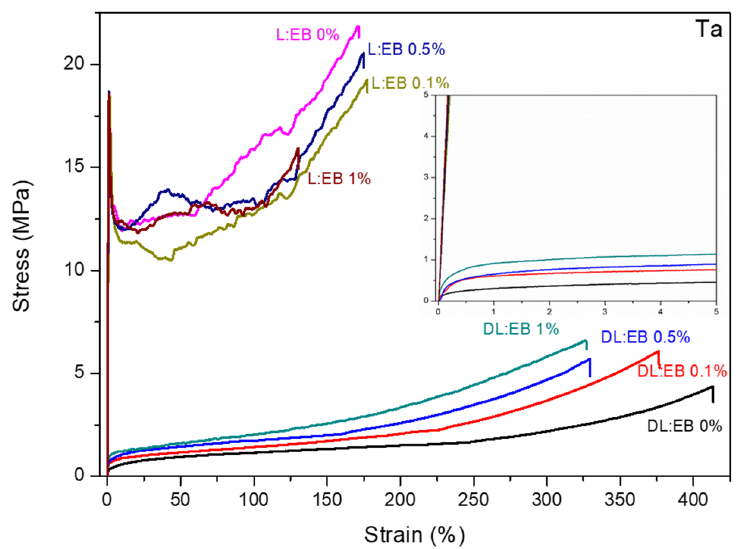
Figure 2. Mechanical properties of DL:EB and L:EB copolymers with different % of CNTs at ambient temperature (Ta).